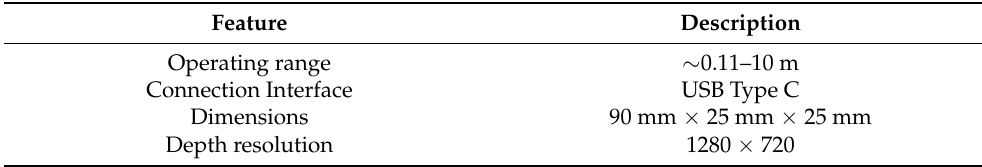
Table 1. Intel Realsense D435 [39].